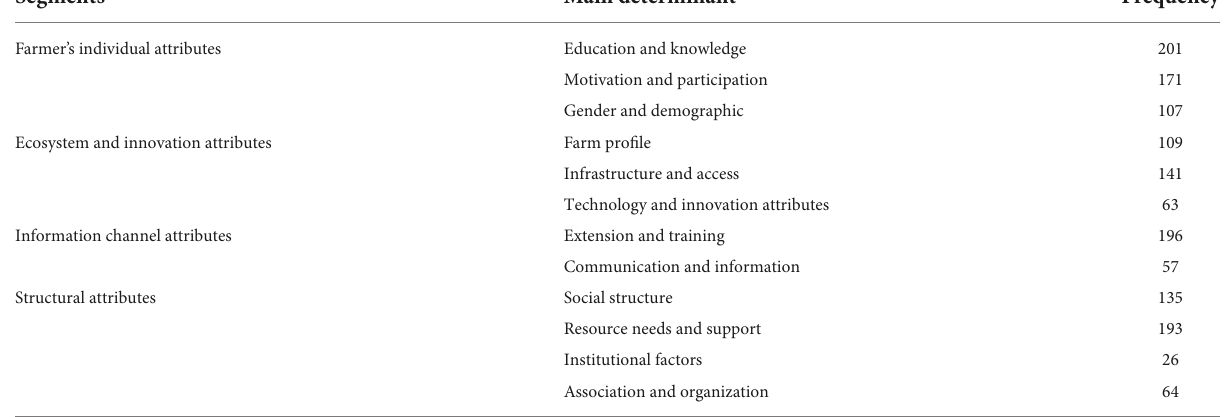
TABLE 3 Segment, main determinant and the frequency mentioned in the